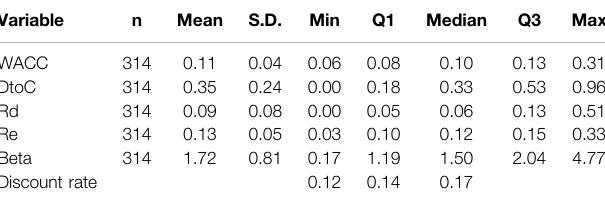
TABLE 1 | Descriptive statistics of WACC and its relevant components for eight biofuel fi rms from 2010 to 2020. Variable